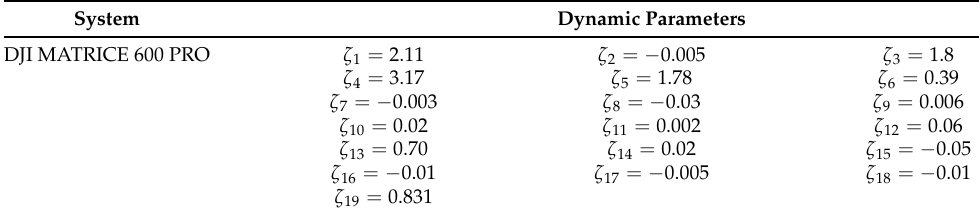
Table 1. Dynamic parameters of the hexacopter aerial platform.